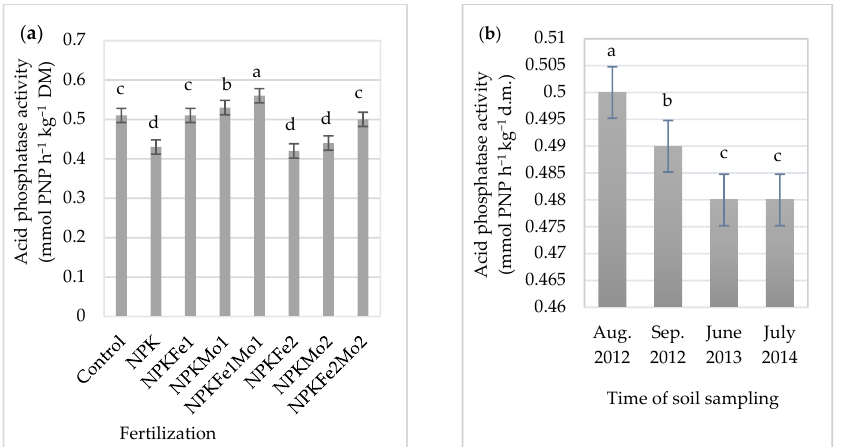
Figure 5. The effects of mineral fertilizer treatment ( a ) and time of soil sampling ( b ) on acid phos- phatase activity. Each bar represents the mean ± SE. The same letters mark no significantly different values ( p ≤ 0.05). sion equation: y = 0.1255 + 0.5382x (Figure 6b).